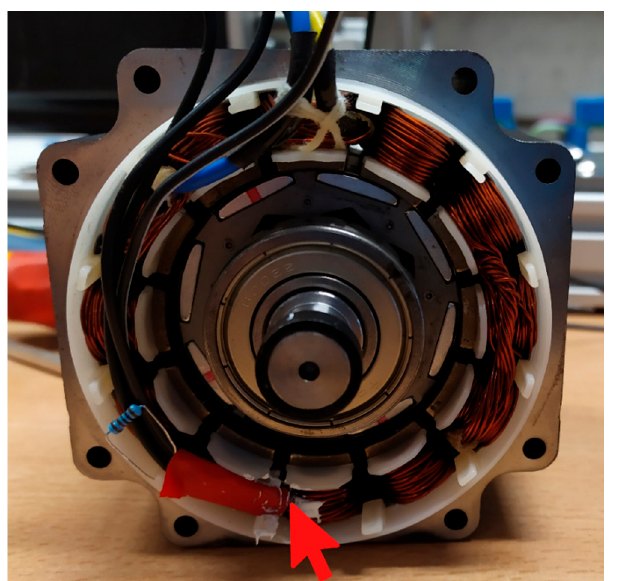
Figure 2. Winding temperature sensor placement (red arrow). Table 1. Tested BLDC motor specifications.